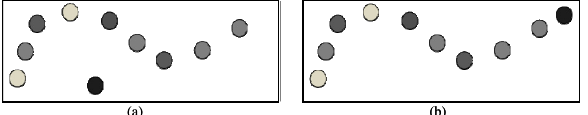
Fig. 12. Law of continuity: anomaly impact.